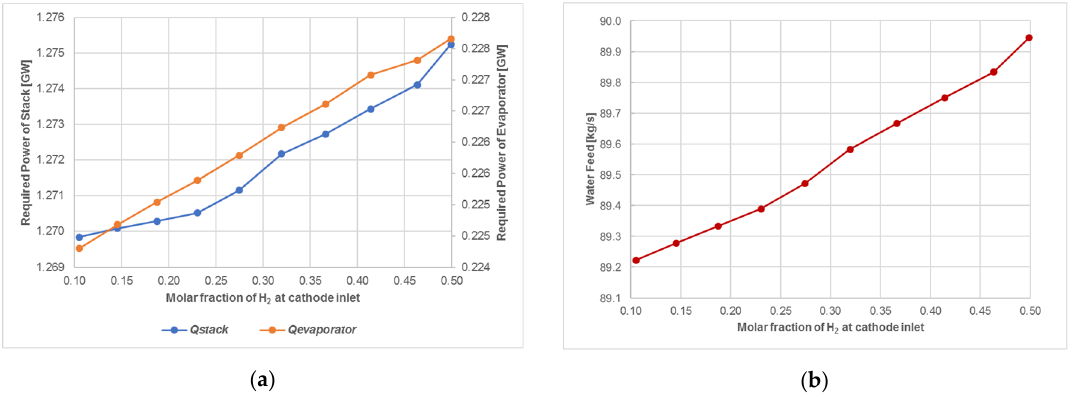
Figure 11. ( a ) Effect of H 2 recirculation at the cathode inlet on the power requirements; ( b ) effect of H 2 recirculation at the cathode inlet on the water feed rate (for 10 kg/s H 2 production).